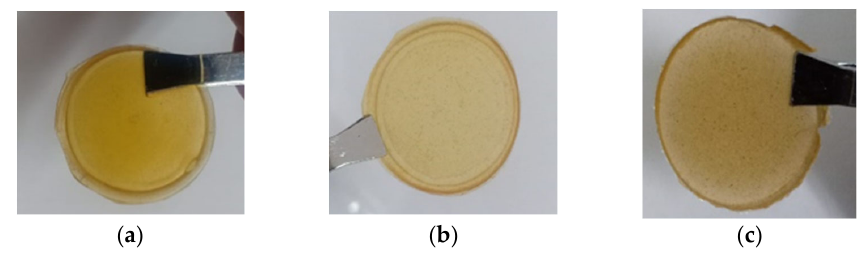
Figure 2. SPE, ( a ) pure CS/PEO, ( b ) CS/PEO/NaClO 4 (CS:PEO:NaClO 4 = 3:2:7.5), ( c ) CS/PEO/NaClO 4 /fly ash